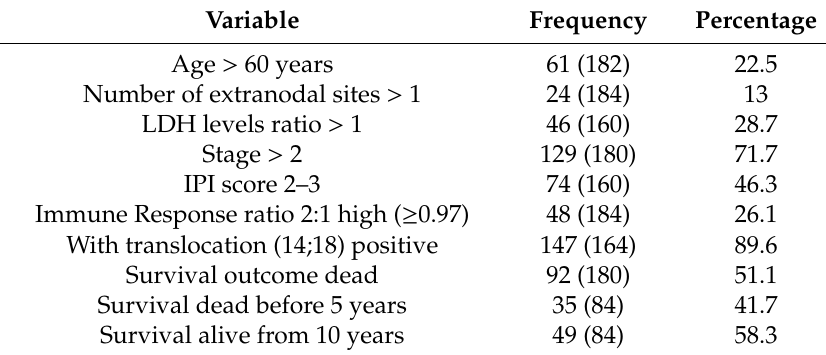
Table 1. Clinicopathological characteristics of the follicular lymphoma